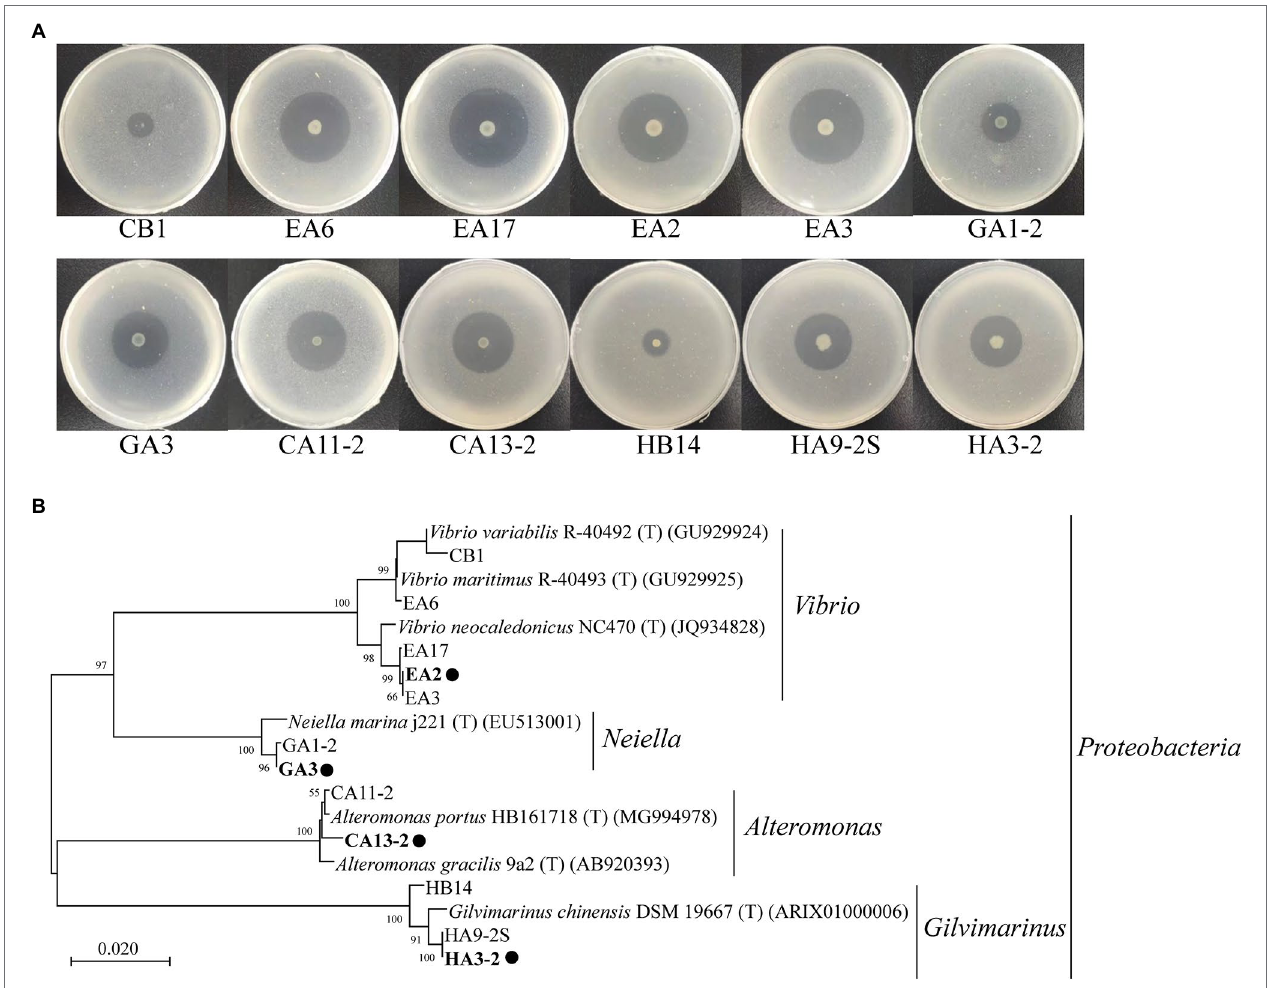
FIGURE 3 | Hydrolytic zones of the isolated 1,3-xylanase-secreting bacteria cultured on plates containing 0.2% 1,3-xylan (A) and the neighbor-joining phylogenetic tree based on the 16S rRNA gene sequences of these strains and their closest neighbors (B) . These strains were cultured at 30 ° C for 5 days for the observation of their hydrolytic zones. The neighbor-joining tree was built using the Kimura 2-parameter model (Kimura, 1980). A bootstrap test of 1,000 replicates was conducted, and values above 50% are shown. Representative strains for detailed study are marked with solid